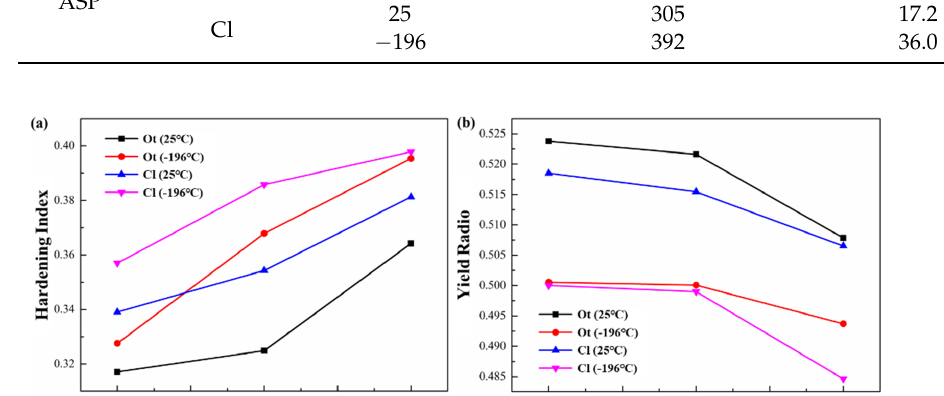
Figure 4. Engineering stress versus strain curves of the Ot and Cl samples of three different plates at different temperatures: ( a ) 25 °C; ( b ) − 196 °C.